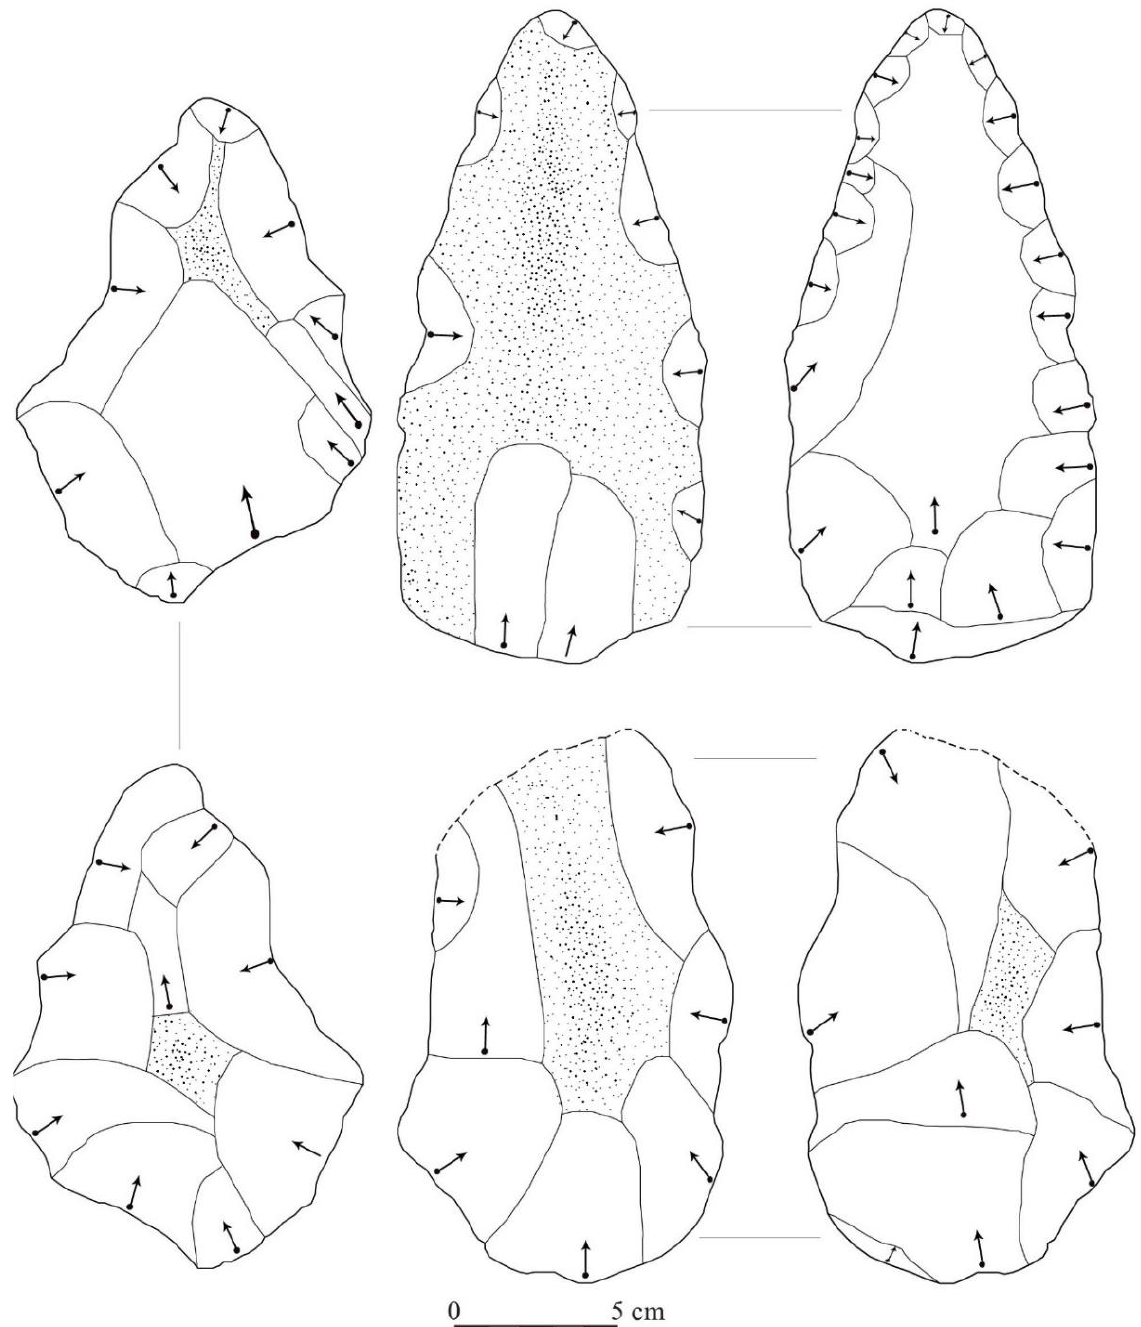
Figure 5: Knapping scars directions and sizes of different sizes of handaxes from the site, arrow show the flaking direction, dots indicate of cortex and dash shows broken part of the